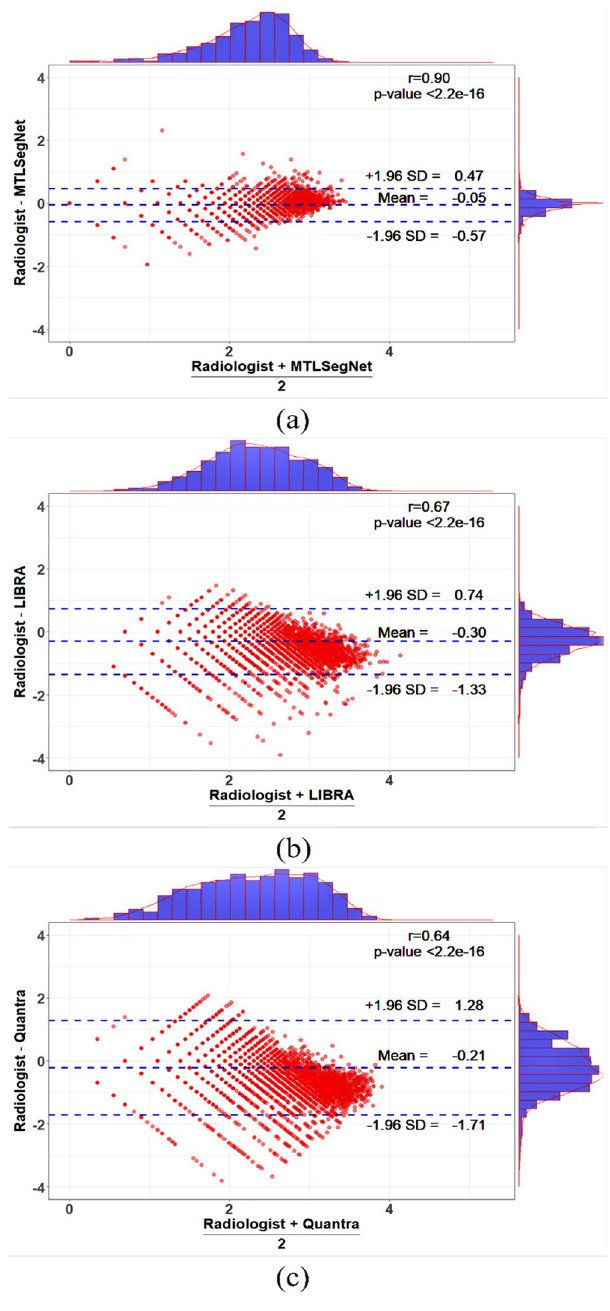
Figure 8. Bland–Altman agreement plots for MTLSegNet, LIBRA, and Quantra with the radiologist-provided PD values for the KUH evaluation dataset. The center blue dotted line shows the average PD values for the two methods. The dotted lines on the top and bottom indicate the LoA range, that is, the value at 1.96 times the standard deviation (SD) in both directions. If the data points are within the LoA, the two methods have strong agreement, otherwise the methods disagree. The Bland-Altman plots are shown for ( a ) MTLSegNet, ( b ) LIBRA, and ( c ) Quantra on the KUH evaluation dataset for the CC-MLO-view